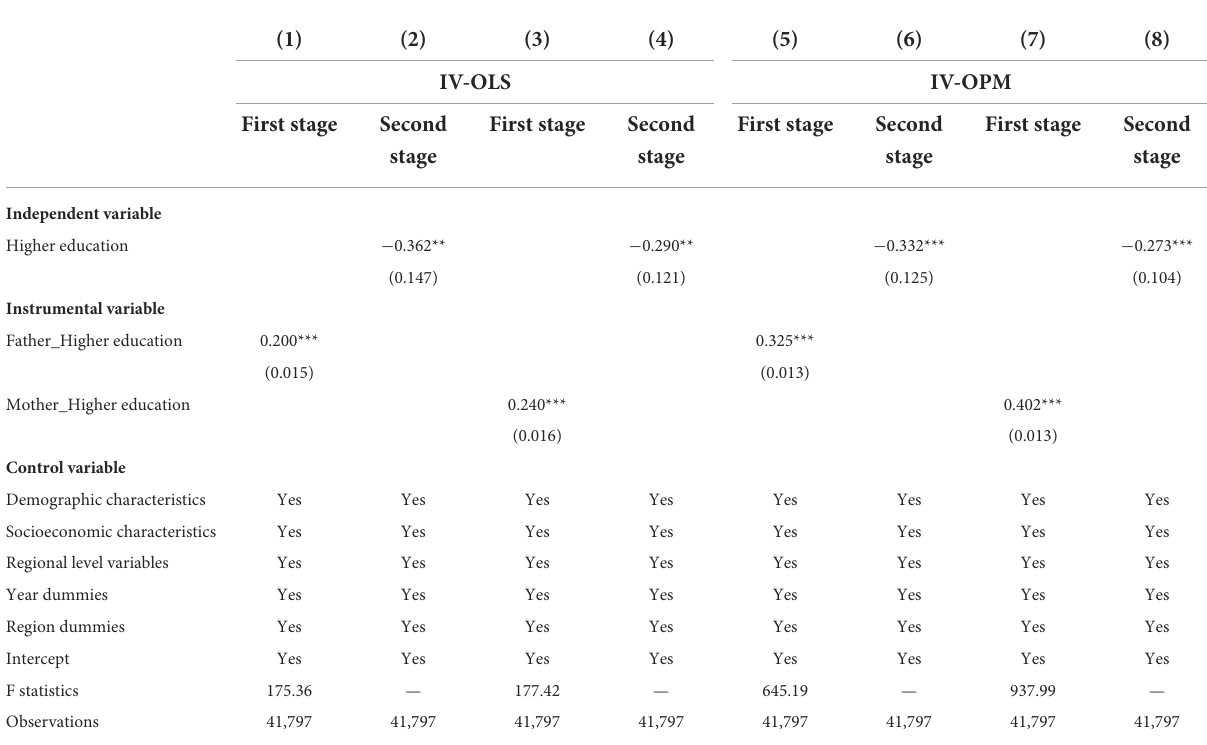
TABLE 4 Results of IV